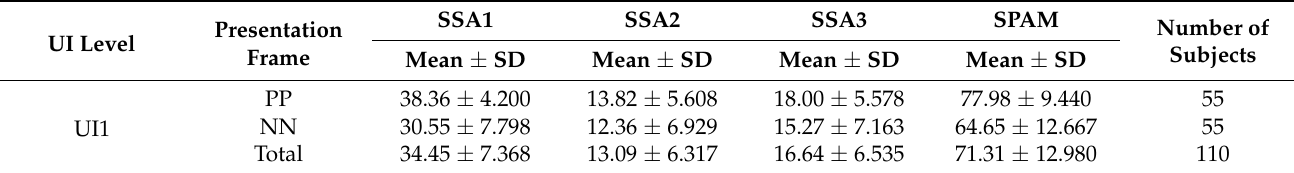
Table 3. The stage and total-SA scores obtained by